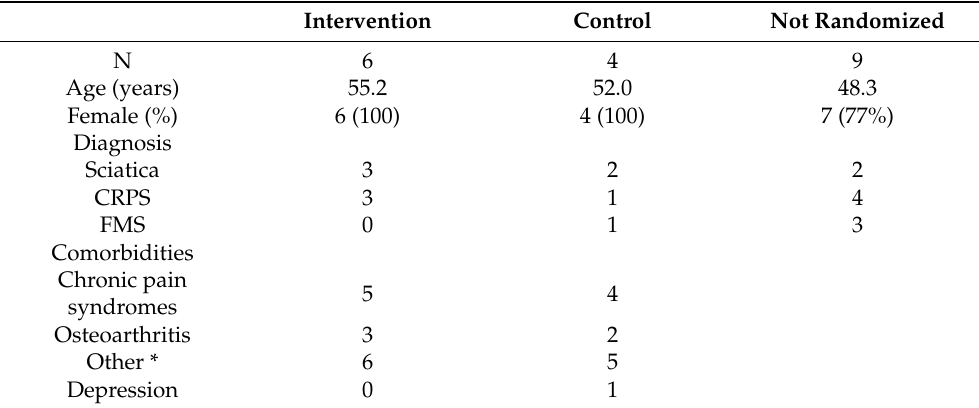
Table 1. Baseline demographics.